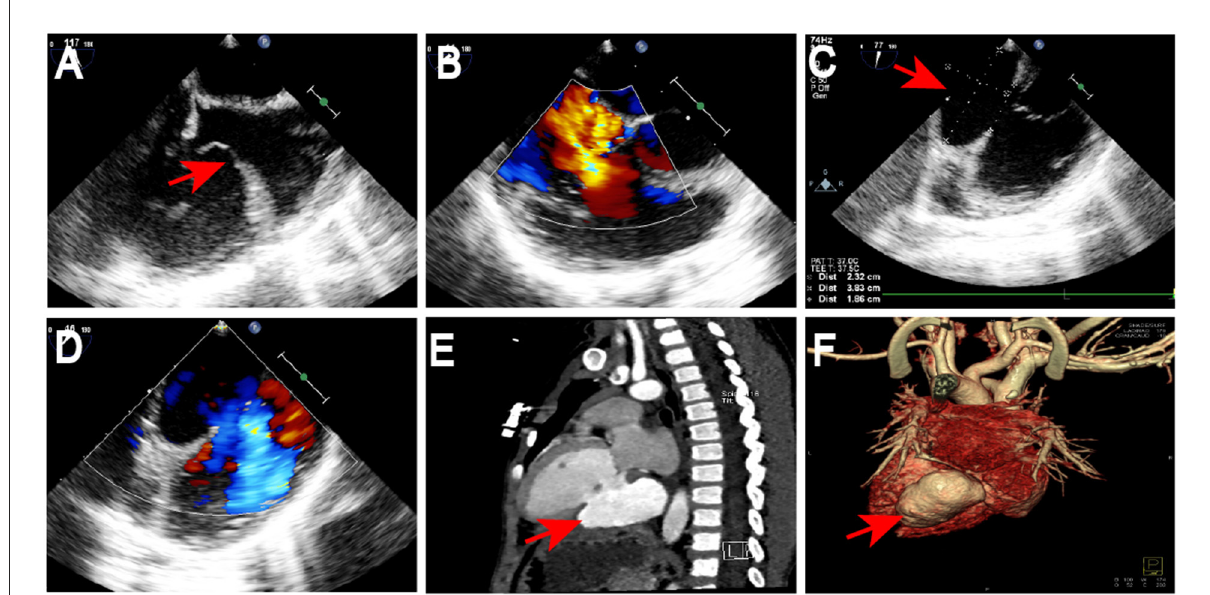
FIGURE1 Preoperative echocardiography and computed tomography results. Anterior tricuspid leaflet prolapse was observed by TTE (red arrow; A ). Tricuspid prolapse resulted in moderate tricuspid regurgitation (B) . TTE revealed avulsion of anterior tricuspid leaflet resulting in moderate tricuspid regurgitation, a 23mm × 38mm giant aneurysm with a 19-mm diameter of the neck in the LVPW (red arrow; C ) and visible blood flow into the aneurysm (D) . CT scan and reconstruction confirmed a massive ventricular aneurysm in the LVPW (red arrow; E,F ). TTE,